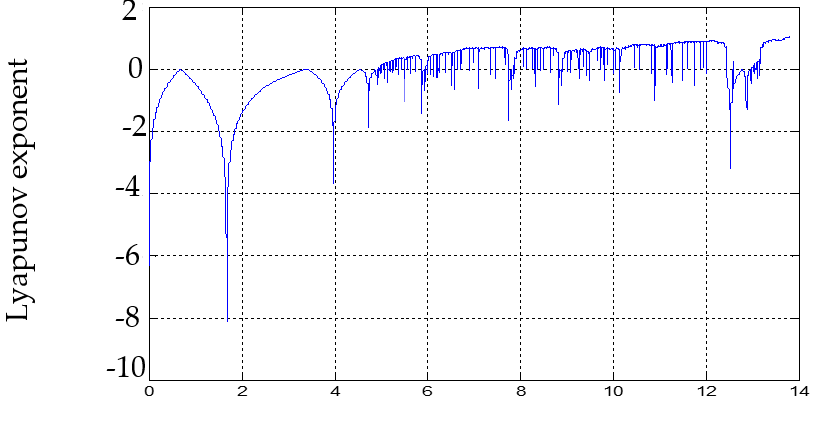
Figure 7. Lyapunov exponent of the modified logistic map [39].